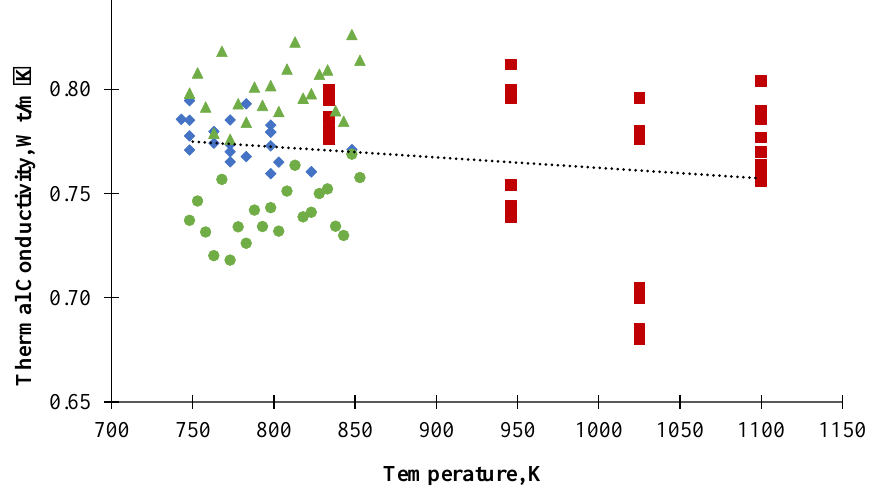
Figure 9. Thermal conductivity results: this work for FLiNaK: ( ⯁ ), Gallagher ( ■ ), Robertson * ( ▲ ), Robertson ** ( ● ). * Calculated with Cp = 1.88 J/g K. ** Calculated with Cp = 1.63 J/g K.